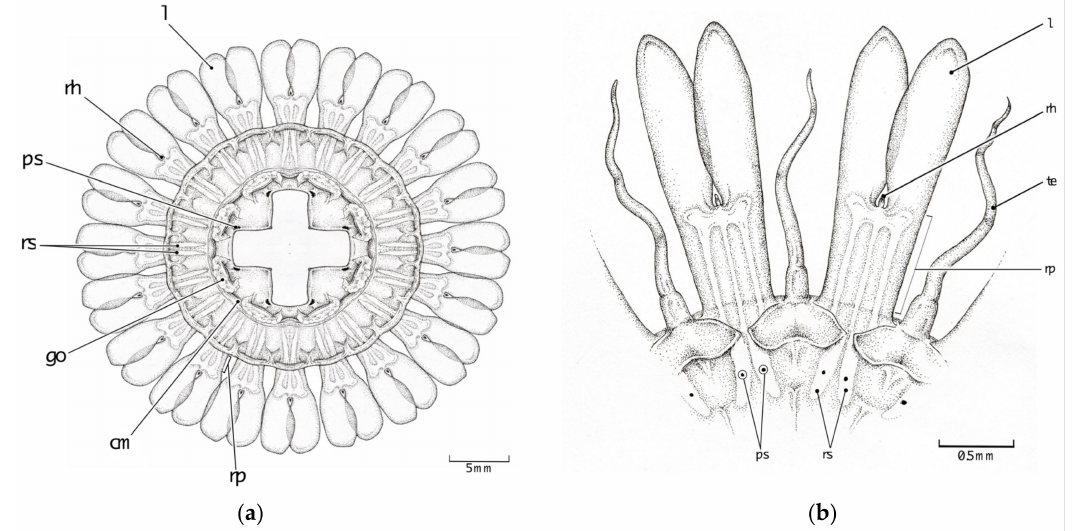
Figure 4. Line drawing showing pigmentation location and patterns for pigmentation observed on the ( a ) oral side of Atolla vanhoeffeni (modified from Russell 1957 [28]) and the ( b ) aboral side of A. tenella (modified from Hartlaub 1909 [12]). cm coronal muscle; go gonad; l lappet; rh rhopalium; te tentacle; rs radial septa; ps pigment spot; rp rhopaliar